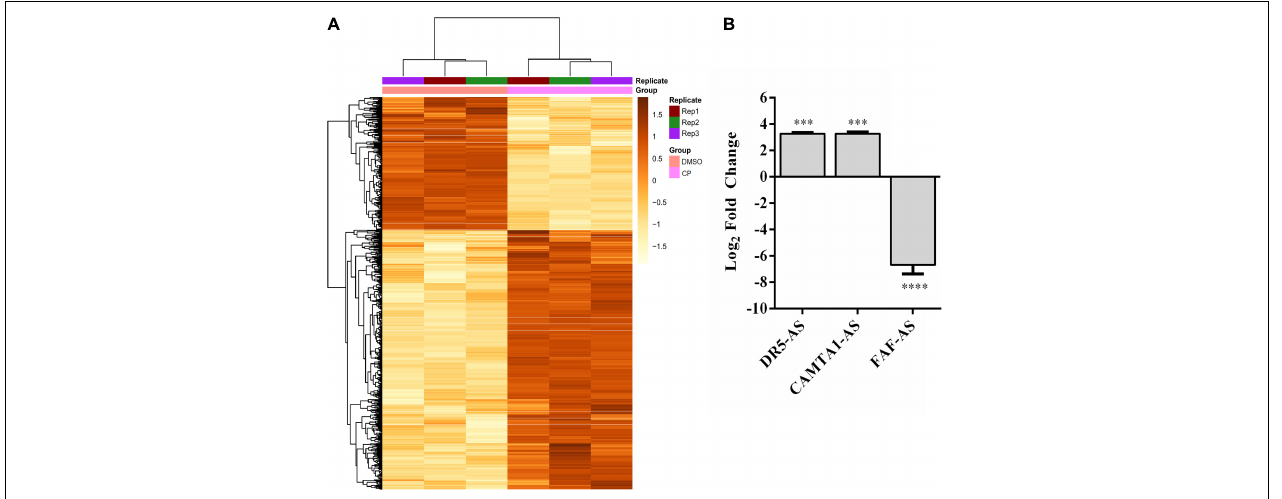
FIGURE 2 | Differentially expressed lncRNAs in cisplatin-treated HeLa cells. (A) Heatmap of top 1,000 differentially expressed transcripts in cisplatin- and DMSO-treated HeLa cells. HeLa cells were treated with cisplatin as explained in Figure 1B . (B) qPCR analyses of candidate lncRNAs. qPCR was carried out with total RNAs isolated from control (0.1% DMSO) and cisplatin-treated HeLa cells. Relative expression of candidate genes was normalized against GAPDH. ∗∗∗ p ≤ 0.001, ∗∗∗∗ p ≤ 0.0001.